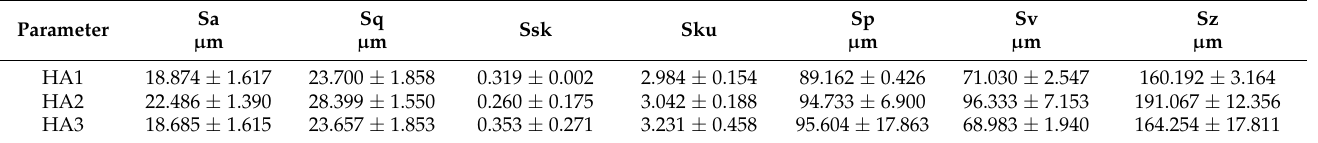
Table 2. Surface geometry parameters of hydroxyapatite (HA) coatings (ISO